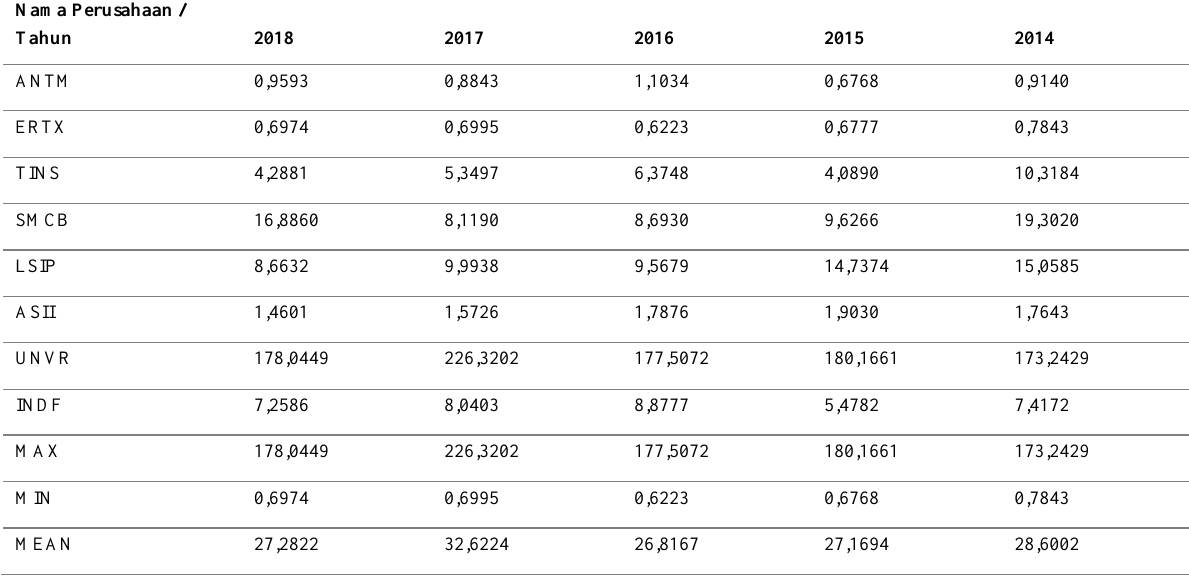
Table 5: Development of Company Performance (Tobin's Q) Year 2014 -